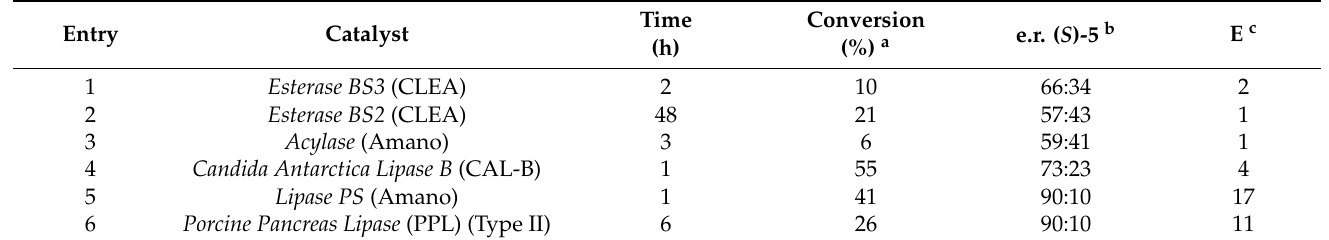
Table 1. Results from screening of enzymes on the acetylation of racemic 4 .